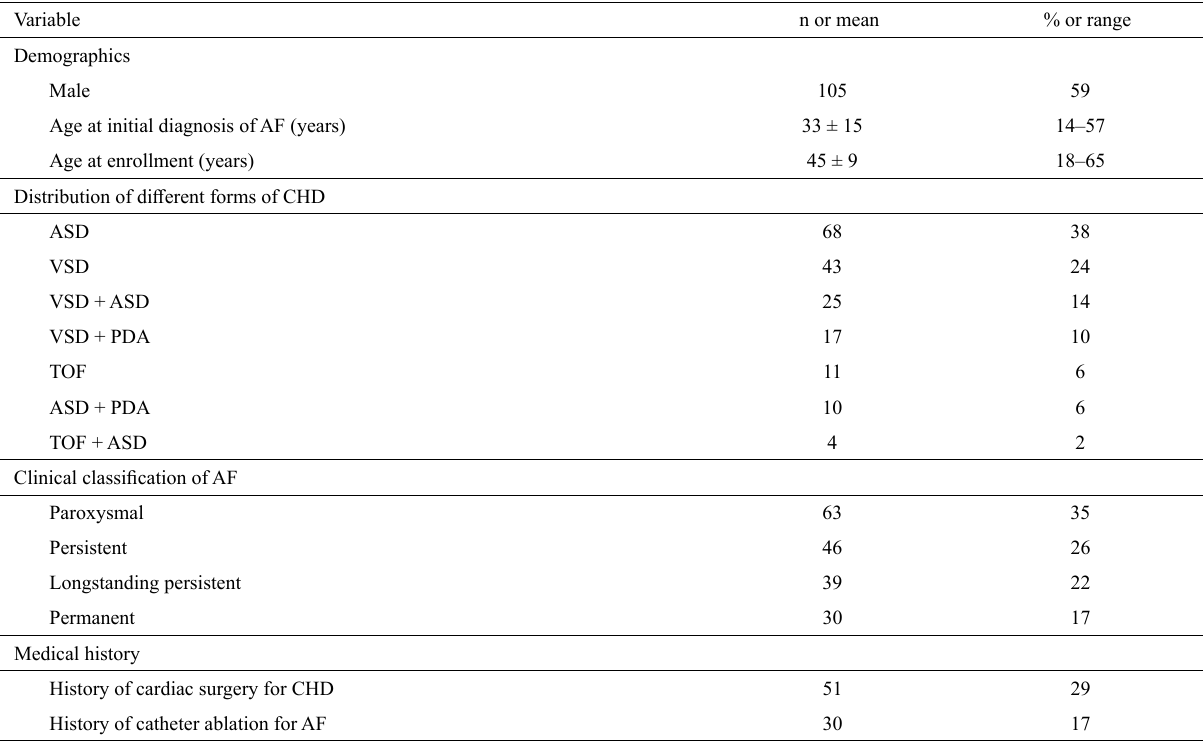
Table 1 – Demographic and baseline clinical characteristics of the 178 patients with familial congenital heart disease and atrial fibrillation. Variable